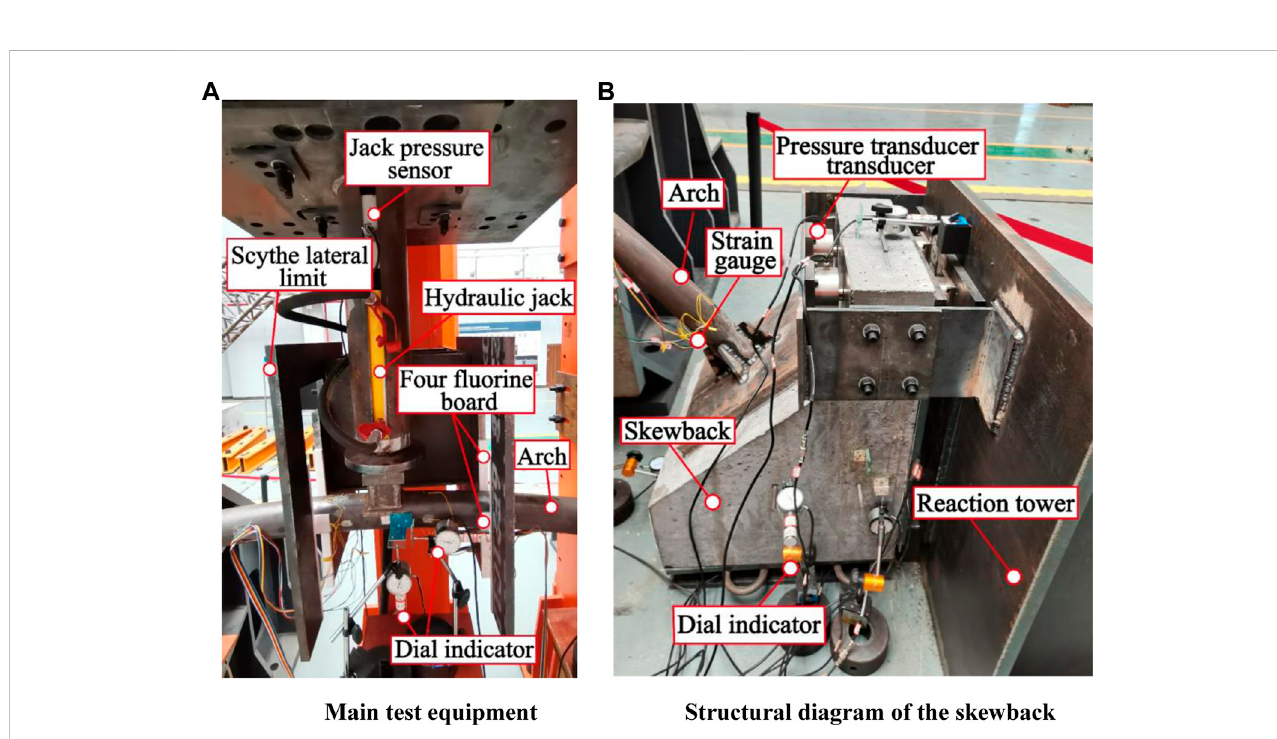
FIGURE 4 Real diagram of local construction: (A) Main test equipment; (B) Structural diagram of the skewback.